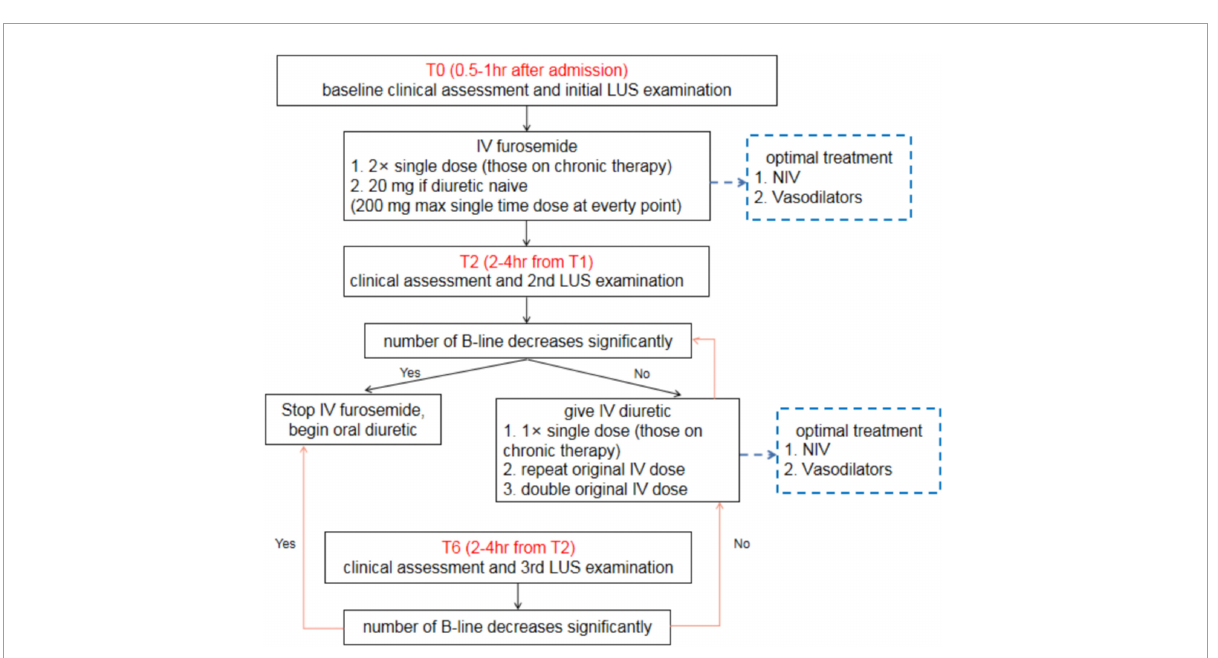
FIGURE8 Clinical algorithm for lung ultrasound assessment among patients with acute heart failure. LUS, lung ultrasound; AHF, acute heart